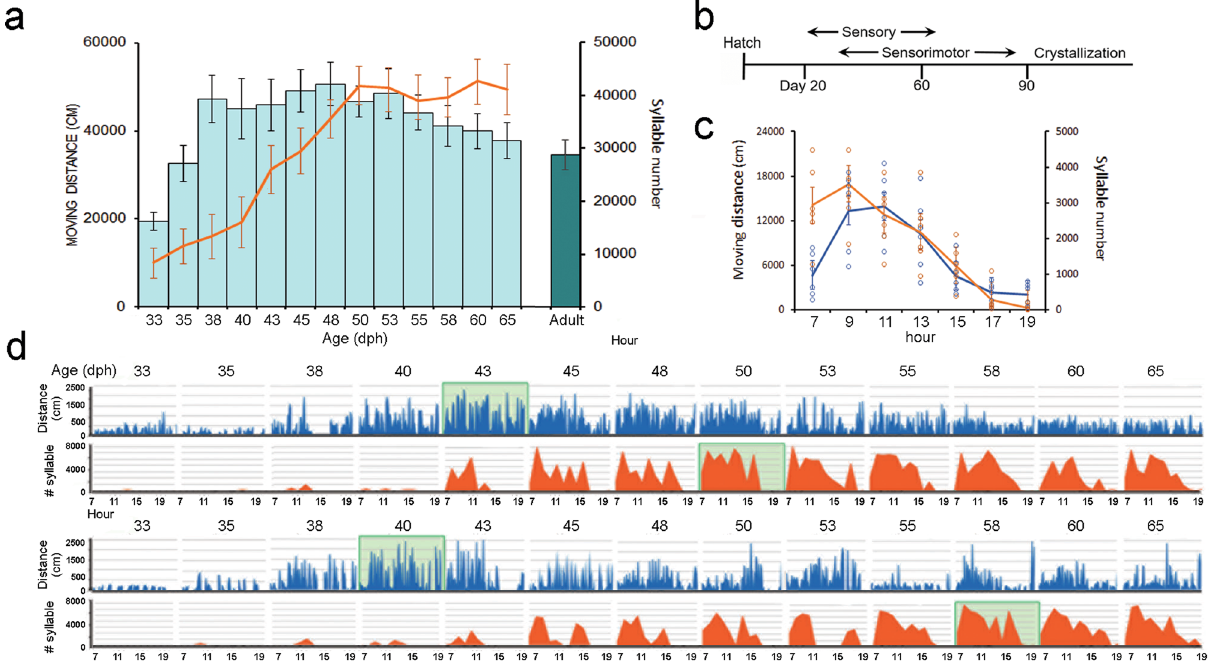
Fig. 1 Developmental trajectories of juvenile locomotor movement are associated with vocal practice. a The amount of locomotor activity of juvenile male fi nches (i.e., mean and standard error of total moving distance, shown in light green bars, n = 13 birds) across part of the sensitive period of vocal learning from 33-65 dph. Each juvenile was housed in a semi-social environment. Each blue dot depicts the mean moving distance of each individual bird at a given age. The adult males (dark blue bar, 183 – 390 dph, n = 10 birds) had less locomotor movement than that of juveniles. The peak of juvenile locomotor activity (around day 38) came before the peak of juvenile song production (after day 50; orange line depicts the mean of the total number of syllables produced from 33-65 dph). b Developmental schedule of vocal learning in zebra fi nches 12 . c The within-day motor activity of juvenile locomotor movement (blue line represents the mean of the total distance moved) and number of song syllables produced (orange line). Each data point is the mean of total moving distance (cm) or total syllable number throughout the day, across the sensitive period from 33 to 65 dph for 6 juvenile males. d Examples show two juveniles ’ developmental trajectories of locomotor activity from 33 to 65 dph. Top panel of each bird: each blue line represents the total moving distance (cm) per 6 min; bottom panel: the orange graph represents mean number of song syllables per hour. The light green block depicts the peak of the locomotor activity or song production in each